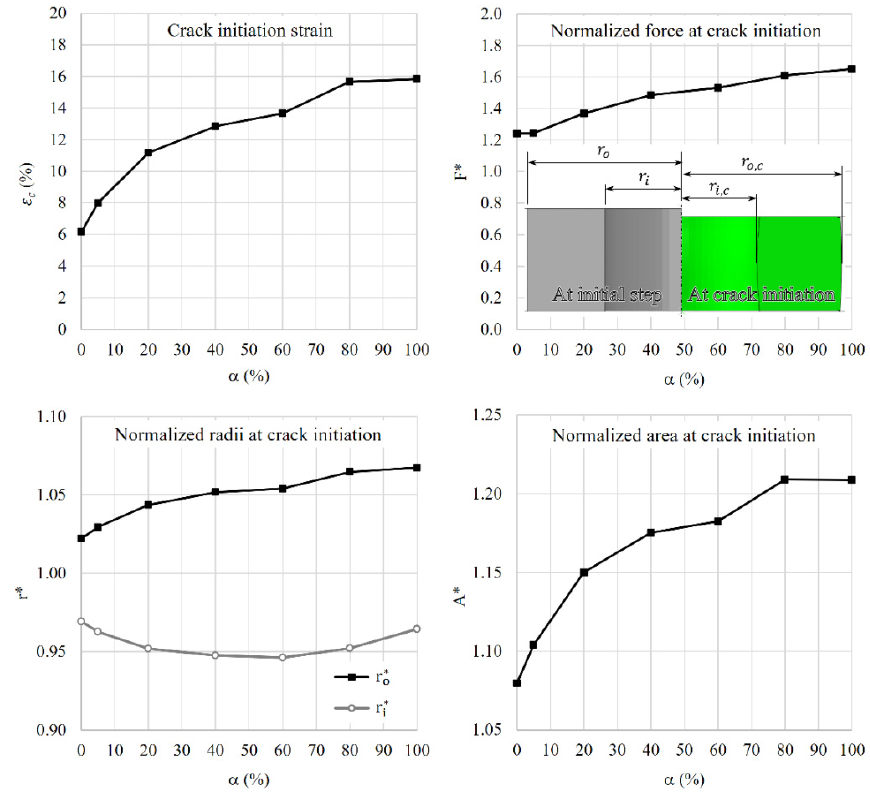
Figure 12. Effect cladding ratio on overall response of the rings.